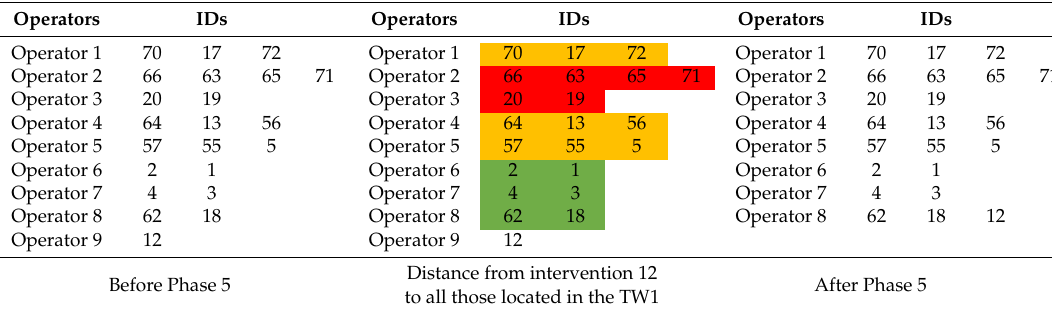
Table 5. Example of support for route optimization (Phase 5).